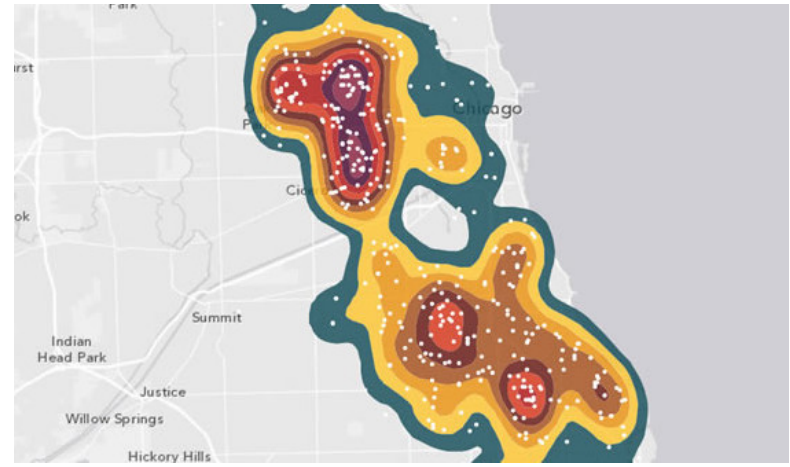
Figure 4. An example of density analysis (adapted from